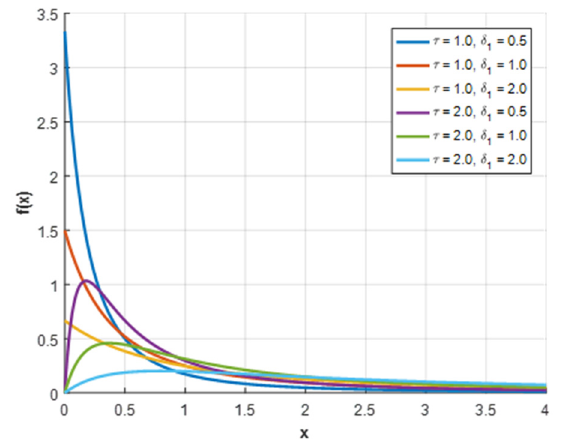
Figure 1. Gamma-Lindley distribution density plots.